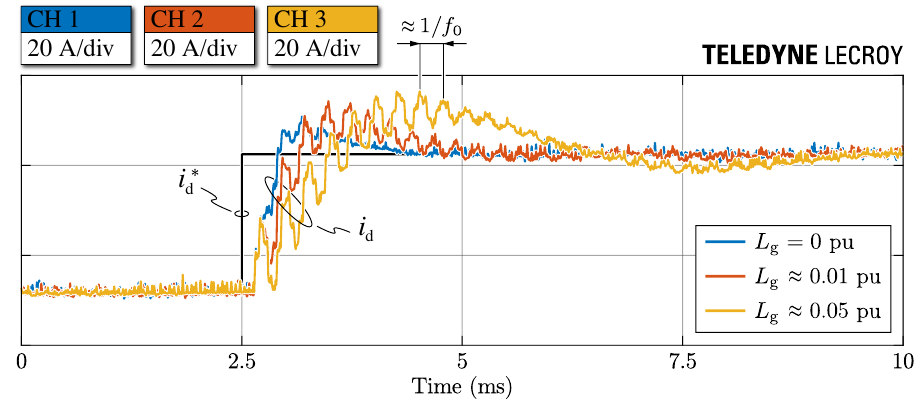
Figure 23. Experimental d-axis current control loop step response between 50% and 100% load for different values of grid inductance. The value of i d is obtained from the DAC of the MCU (i.e., as a voltage value between 0 and 3.3V) and then rescaled, thus showing a high amount of